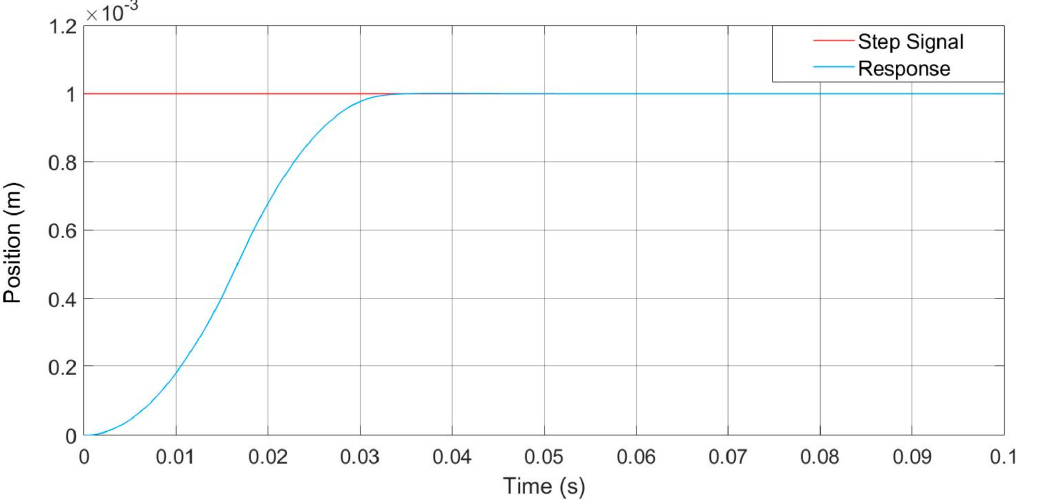
Figure 14. System response under external interference. Figure 15 shows the response time and steady state of the aerostatic bearing slideway control system under 0 kg, 5 kg, 10 kg, and 15 kg loads. It can be found that with the increase of implemented load, the overshoot and response time of the step signal get in- creased as well. If the load mass is over range, it will cause notable instability of the system and seriously affect the processing quality during manufacturing. Therefore, it is neces- sary to tune the PID parameters according to different working environments. Since not